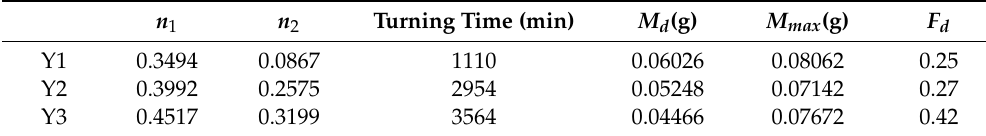
Figure 4. Imbibition curves for samples in regular and log-log coordinates. ( a ) is the regular coordinates, ( b ) is log-log coordinates. The slopes of linear part are marked in this figure. Table 2. Slopes and typical points of imbibition curves.